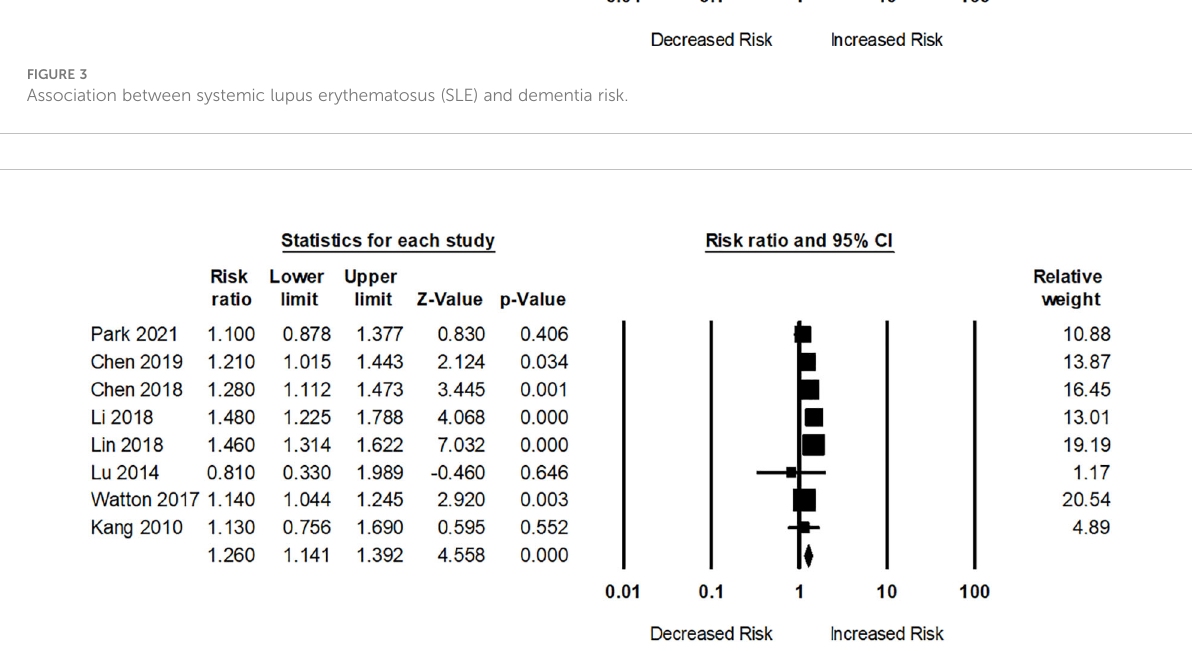
FIGURE 4 Association between Sjogren ’ s syndrome (SS) and dementia